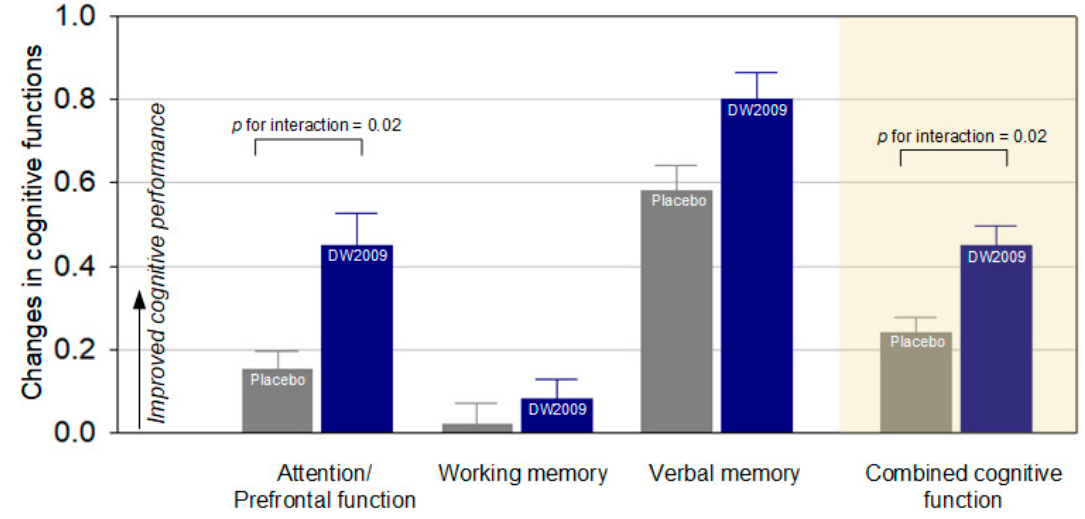
Figure 2. Differences in changes in composite z scores of each cognitive domain and combined cognitive function between the placebo-treated and DW2009-treated groups. Error bars indicate standard errors.